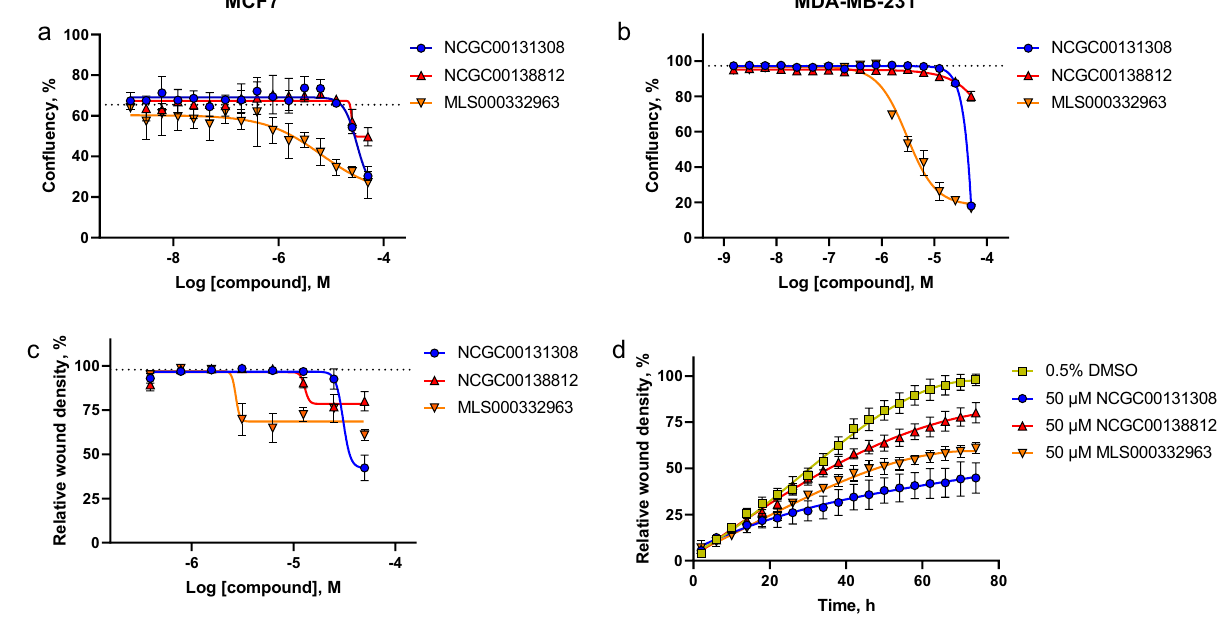
Figure 5. Dose-dependent effects of the selected compounds on cell proliferation and migration. MCF7 ( a ) and MDA-MB-231( b ) cells were grown in the presence of compounds NCGC00131308, NCGC00138812 or MLS000332963 for 72 h and the confluency of the cell monolayer was measured. As control, cells were treated with 0.5% DMSO. The confluency of DMSO treated MCF7 cells was 65.47% ± 2.02 and MDA-MB-231 97.32% ± 0.84, respectively, and are depicted as dotted lines. ( c , d ) The migration of MDA-MB-231 cells was monitored in the presence of compounds NCGC00131308, NCGC00138812 or MLS000332963 at different concentrations using a scratch wound assay. ( c ) Concentration response analysis of the compounds at 72 h post treatment. The wound closure of DMSO treated control cells was 97.86% ± 3.17 and is depicted as a dotted line. ( d ) The effect of the compounds at 50 μM concentration on the migration of MDA-MB0231 cells over the course of treatment. Data are shown as means of triplicate measurements and standard